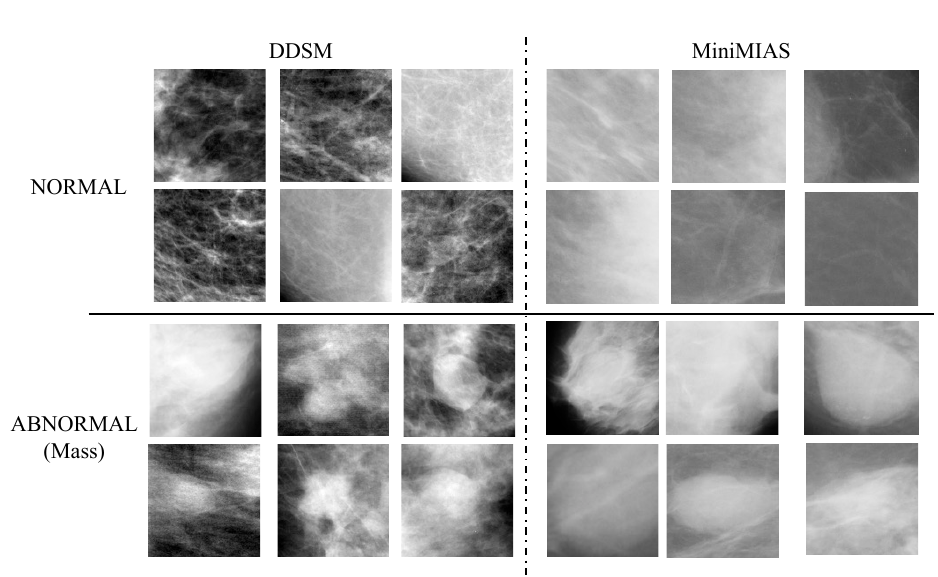
Figure 5. Examples of ROI for normal and abnormal cases from the Mini-MIAS and DDSM da- tasets.